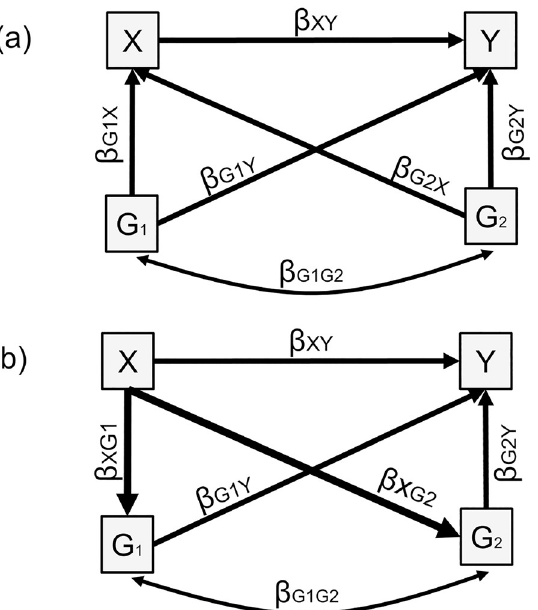
Fig 4. Genetic confounding, two polygenic scores. Fig 4A represents the underlying causal model. Fig 4B represents the model to calculate the confounding effect, which is equal to: b are standardized, the genetic confounding effect can also be obtained based on 4a by b